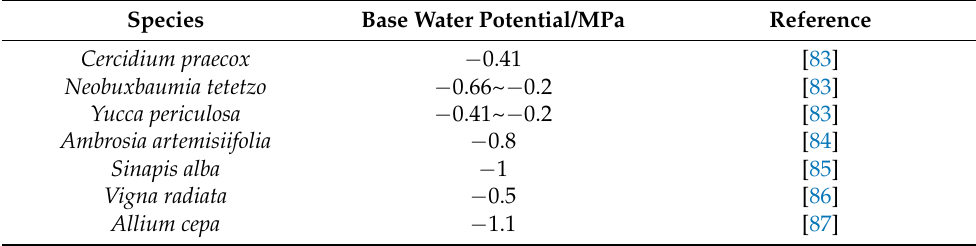
Table 2. Basal water potential of germination of some